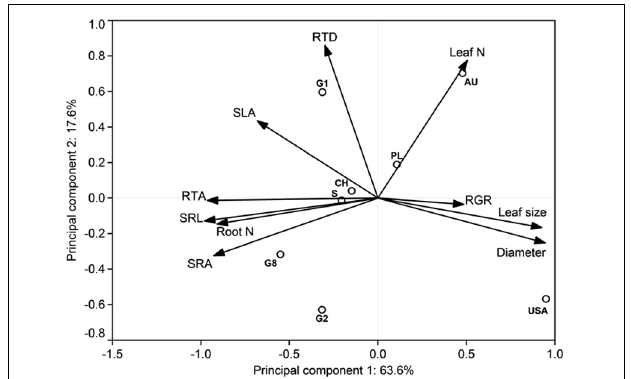
FIGURE 1 | Distribution of relative growth rate and root and leaf morphological properties in the orthogonal plane of the Principal Components Analysis for the eight poplar demes and the percentage contribution of the respective axis to total variability, n = 4–15 individuals per deme. G1, G2, G8, CH, S, PL, AU and USA stand for the eight